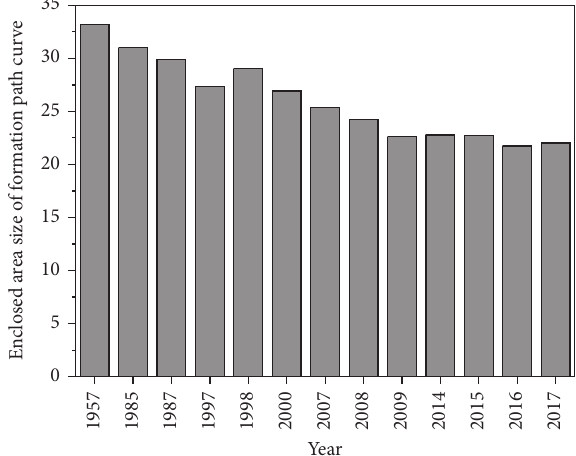
Figure 7: Enclosed area size of the formation path curve.